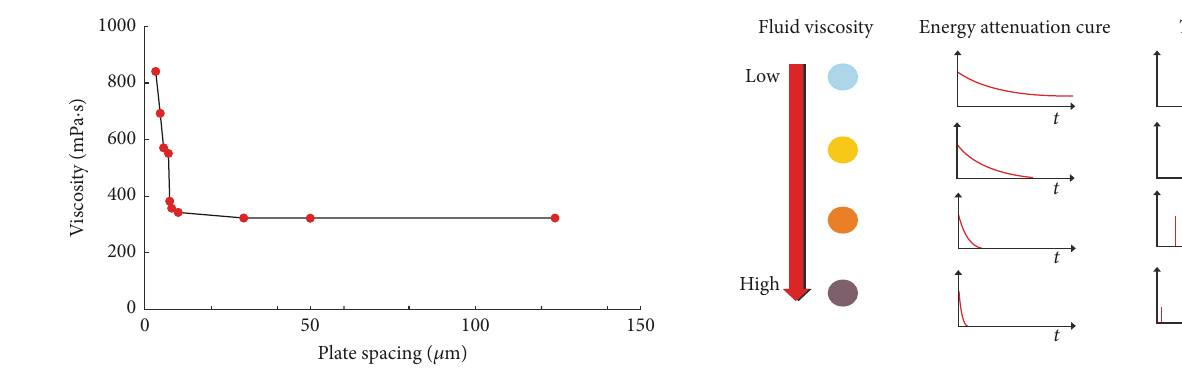
Figure 2: Viscosity variation of glycerol with different plate spacing.